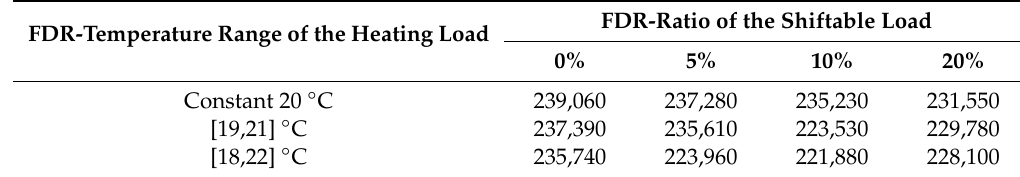
Table 5. Costs of the system operation with FDR of electric and thermal load (Unit: ¥). FDR-Ratio of the Shiftable Load FDR-Temperature Range of the Heating Load